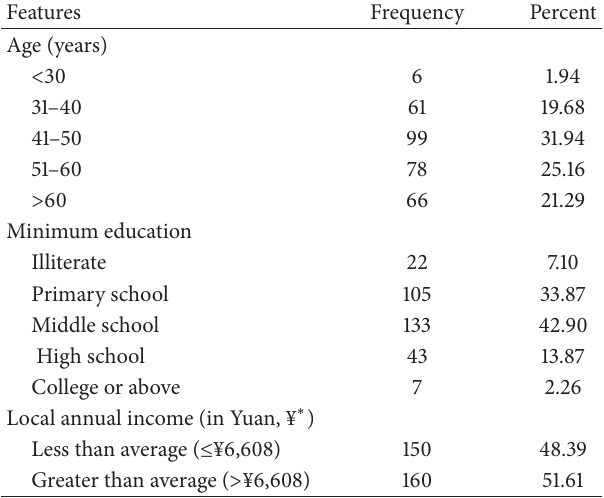
Table 3: Demographic characteristics of nonindustrial family forest landowners sampled in Fujian and Jiangxi provinces.